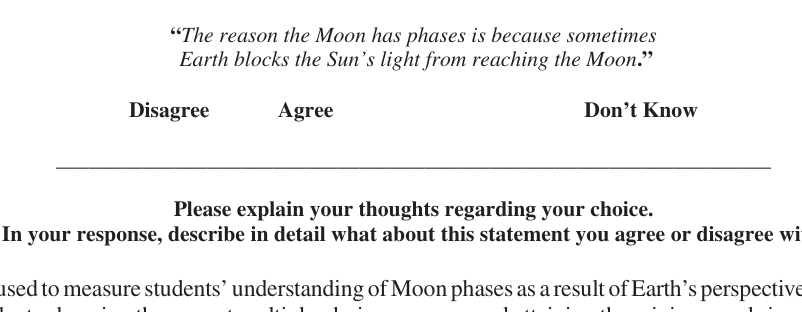
FIG. 14. Assessmentusedtomeasurestudents ’ understandingofMoonphasesasaresultofEarth ’ sperspectiveoftheMoon ’ shalf-litside. The distributions of students choosing the correct multiple-choice response and attaining the minimum rubric score can be found in Fig. 7.